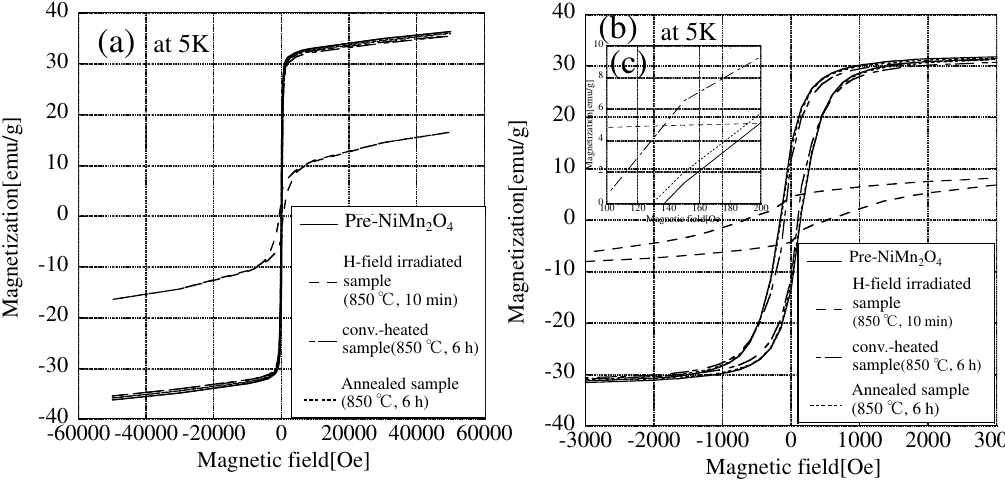
Figure 4. M-H loops at 5 K of NiMn 2 O 4 . ( a ) Full loop, ( b ) magnification ( − 3000–3000 Oe); and ( c ) magnification (100–200